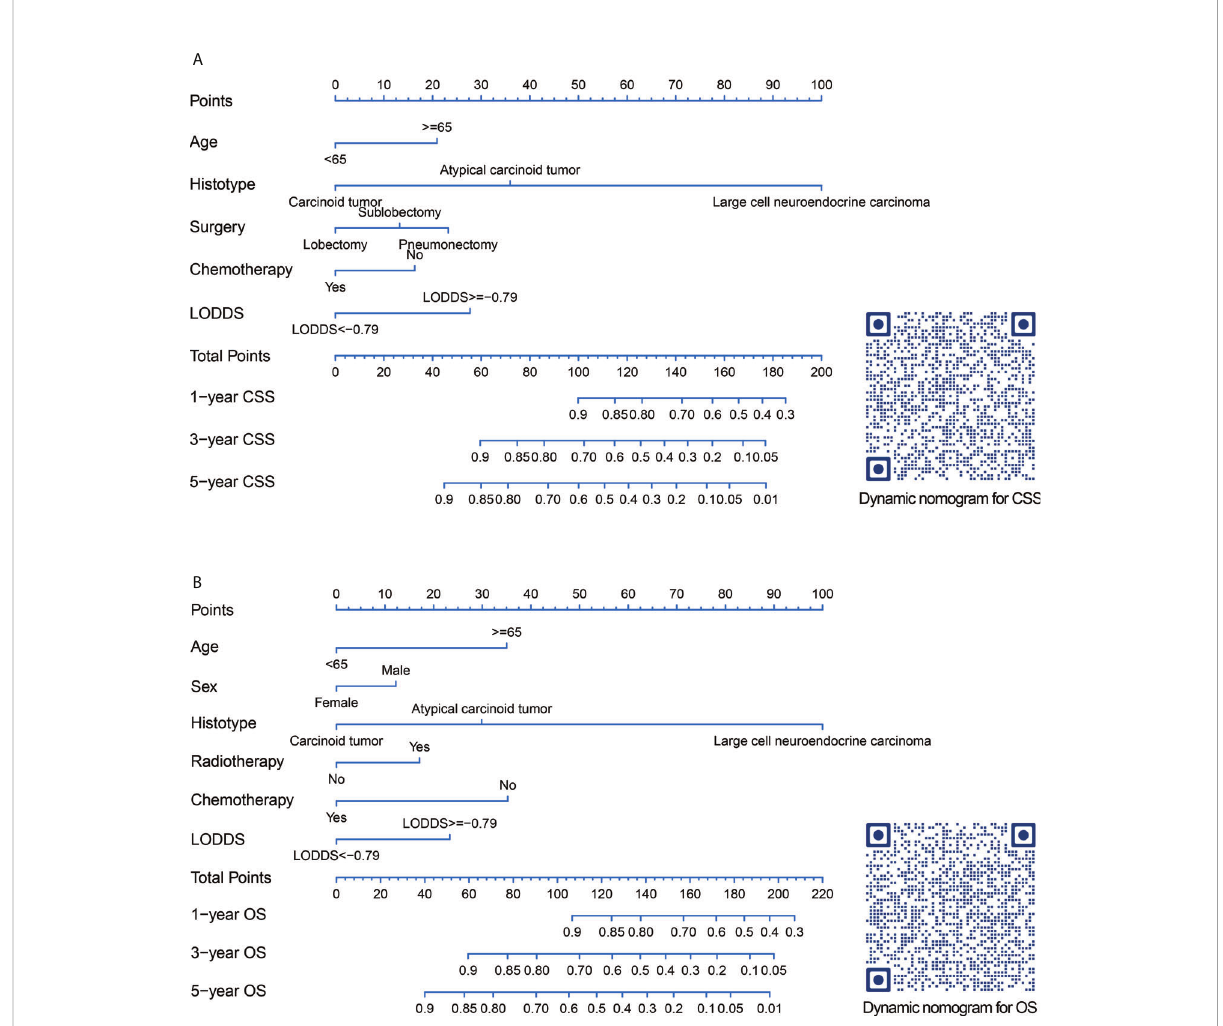
FIGURE 2 Nomograms and quick response codes of the webservers of the nomograms to predict 1-, 3- and 5-year CSS (A) and OS (B) for patients with node-positive lung neuroendocrine carcinoma after surgery. CSS, lung cancer-speci fi c survival; OS, overall survival; LODDS, log odds of positive lymph